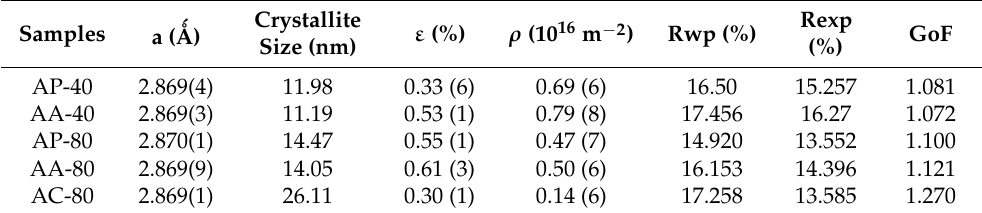
Table 2. Crystallographic parameters and Rietveld refinement results obtained by Rietveld refinement of the A (Fe 80 (NiZr) 8 B 12 ) alloy.